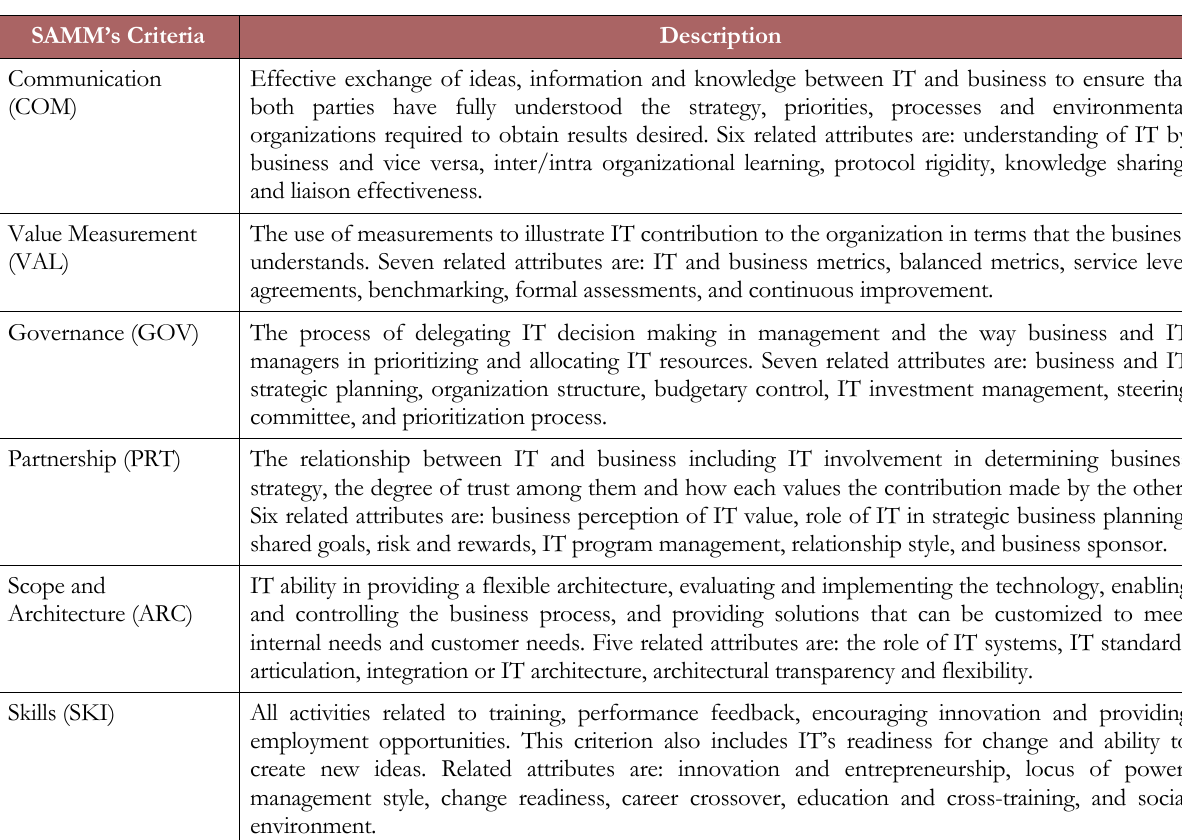
Table 1. IT-Business Strategic Alignment Maturity Model’s Criteria (Luftman,